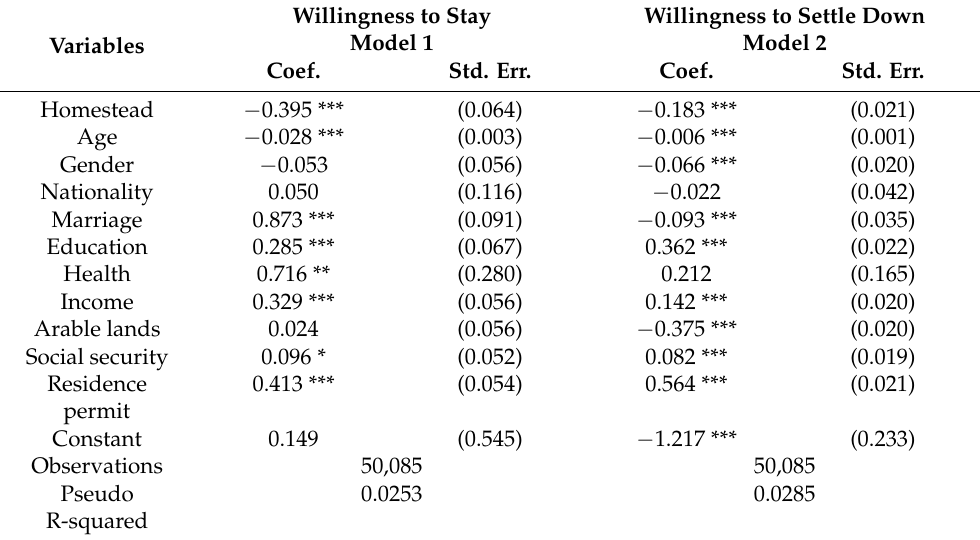
Table 3. Benchmark regression